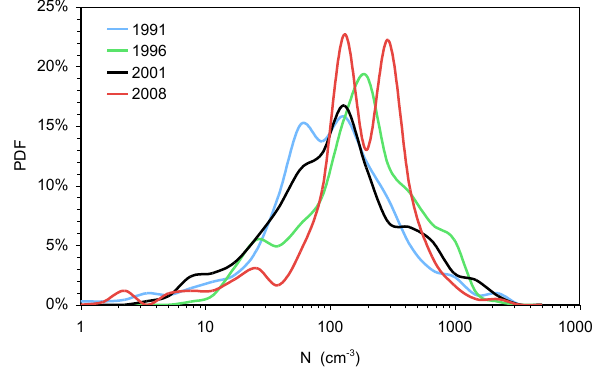
Fig. 8. Median number size distributions fitted with lognormal func- tions in four sub-populations, with Hoppel diameters (DHO, nm) varying between 30nm and 150nm. Median total number concen- trations (N, cm − 3 ) in each sub-population are also plotted as func- tion of median DHO in each sub-population. For comparison total number concentrations scaled by a factor of 20 are plotted as a func- tion of median DHO for the continental reference station Melpitz, Germany.